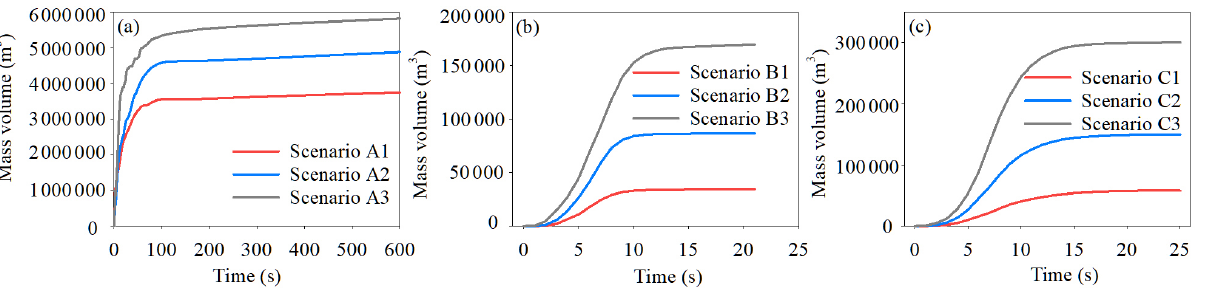
238 086 m 3 s − 1 , as well as 386 359 and 373 449 m 3 s − 1 ,